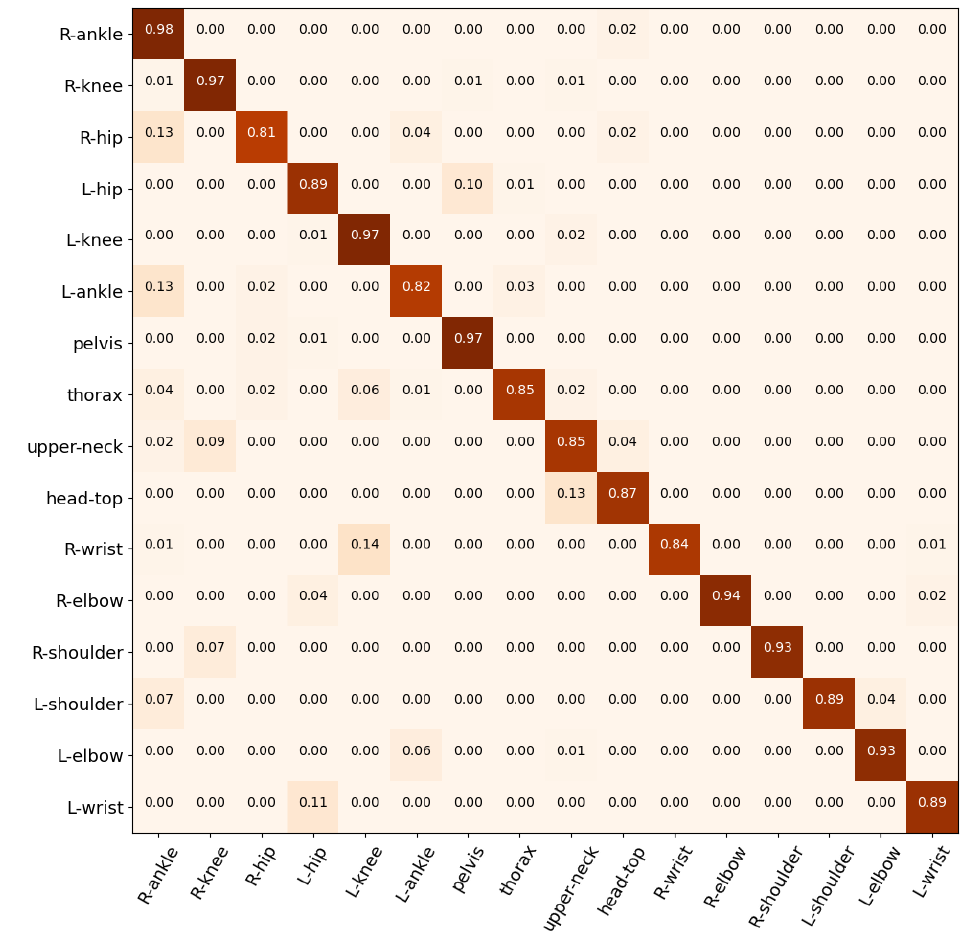
Figure 15. Confusion matrix results on MPII of our proposed method.